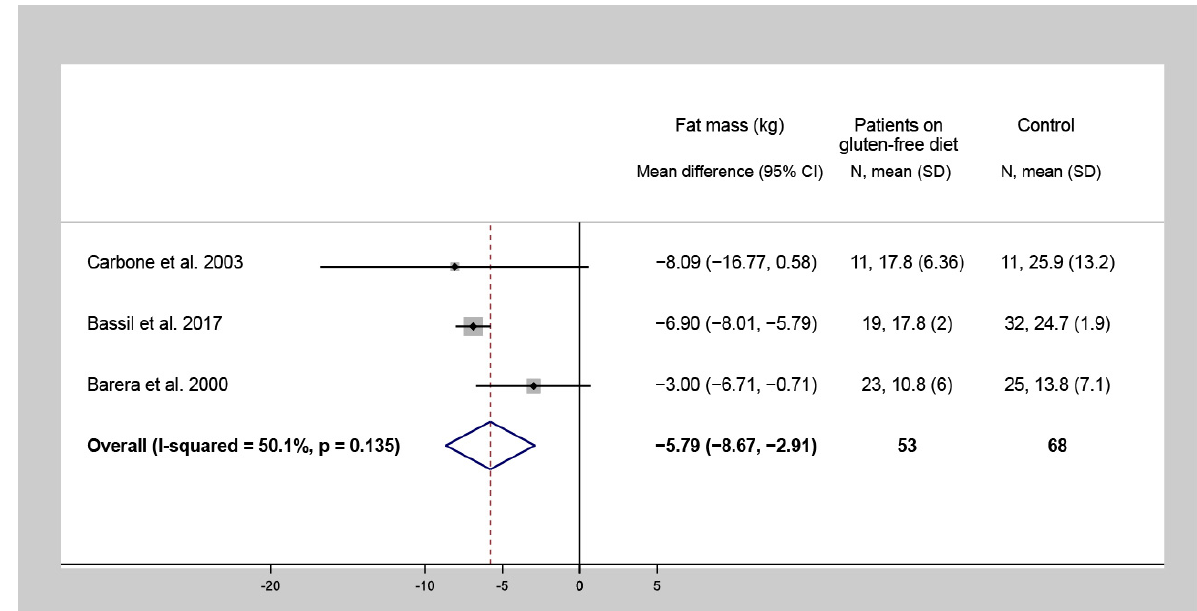
Figure 2. Forest plot of studies comparing fat mass of celiac disease patients after at least a one-year gluten-free diet to that of the same patients at diagnosis (a positive number indicates a gain in fat mass following a gluten-free diet). N: Number of patients.